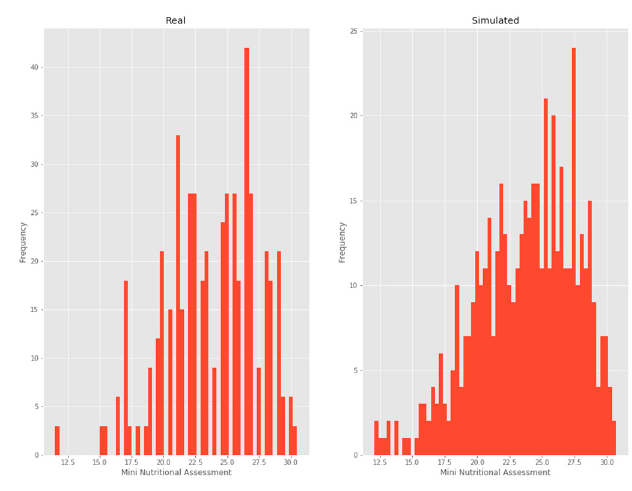
Figure 7. Mini-nutritional assessment.